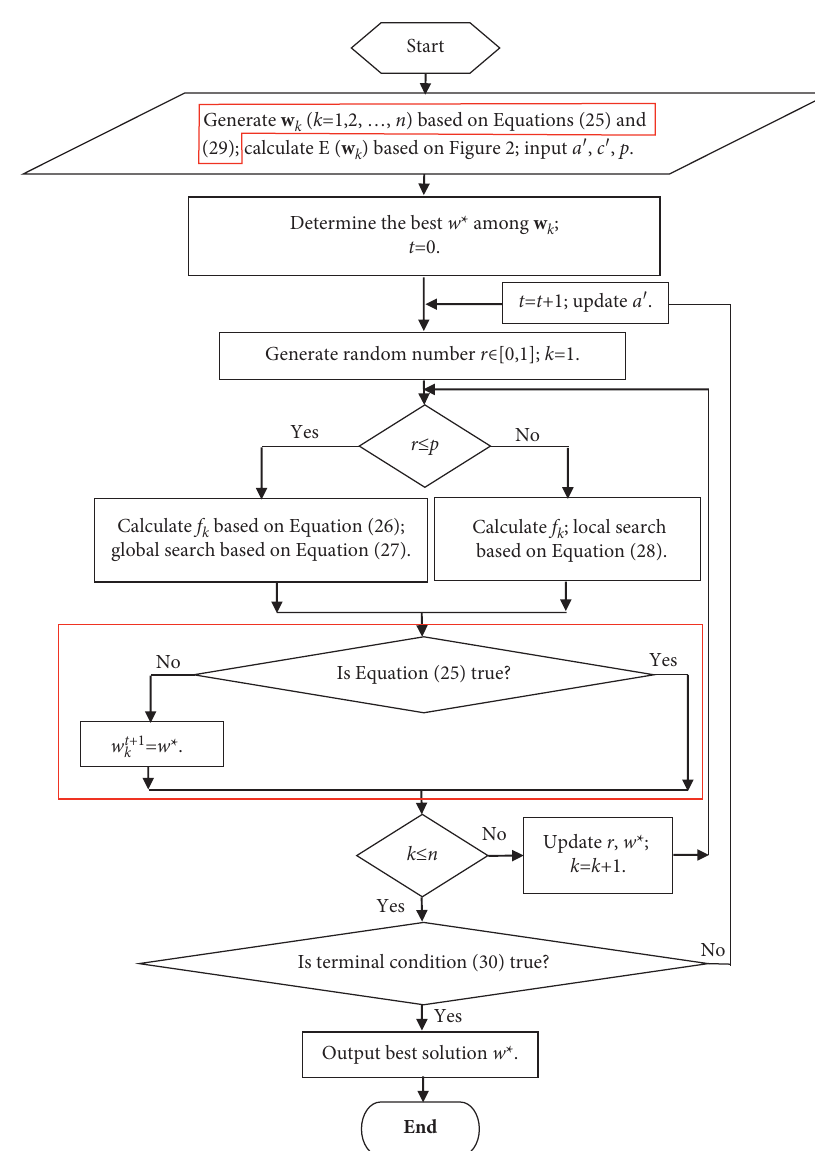
Figure 3: Program flowchart of using IBOA to solve the problem of optimal cross-sectional dimension of rods for the 3-RRR